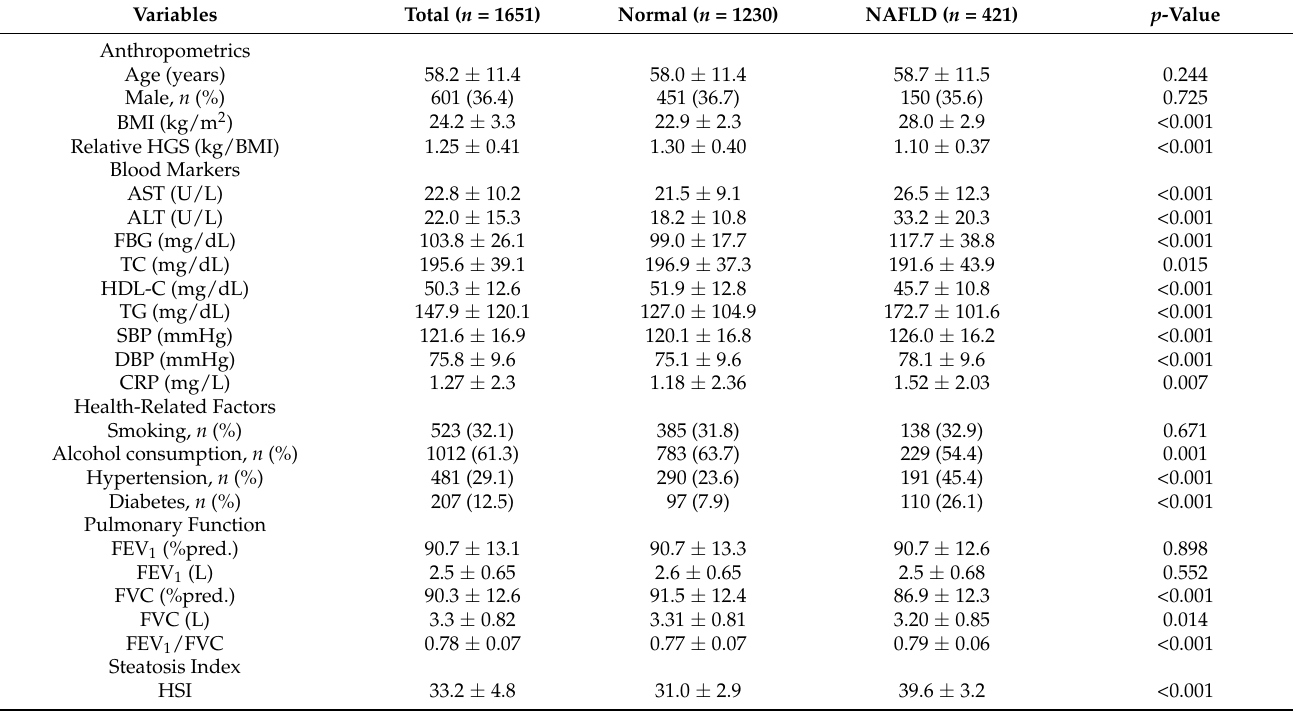
Table 1. Measured parameter values for NAFLD status by